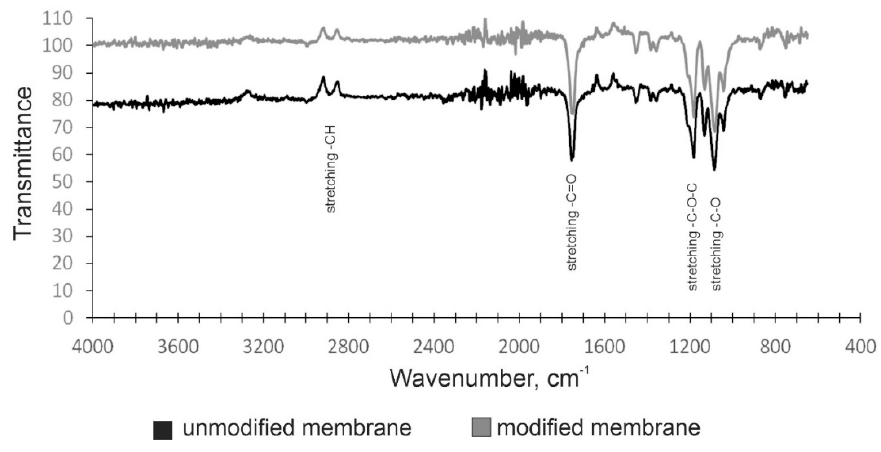
Figure 8 FTIR-ATR spectrum of the unmodified and modified samples. Figure 8. FTIR-ATR spectrum of the unmodified and modified